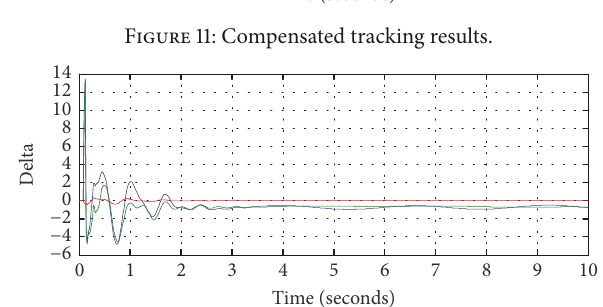
Figure 12: Compensated actuator deflections.